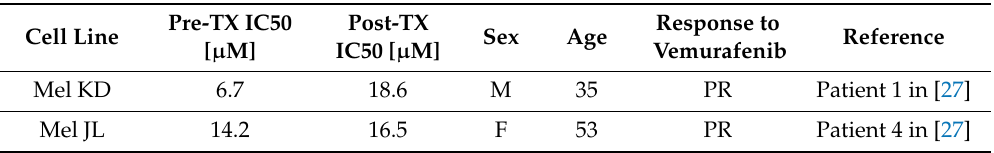
Table 1. IC50 values and patient data of the cell line pairs. (M = male, F = female, PR = partial response, n.a. = not